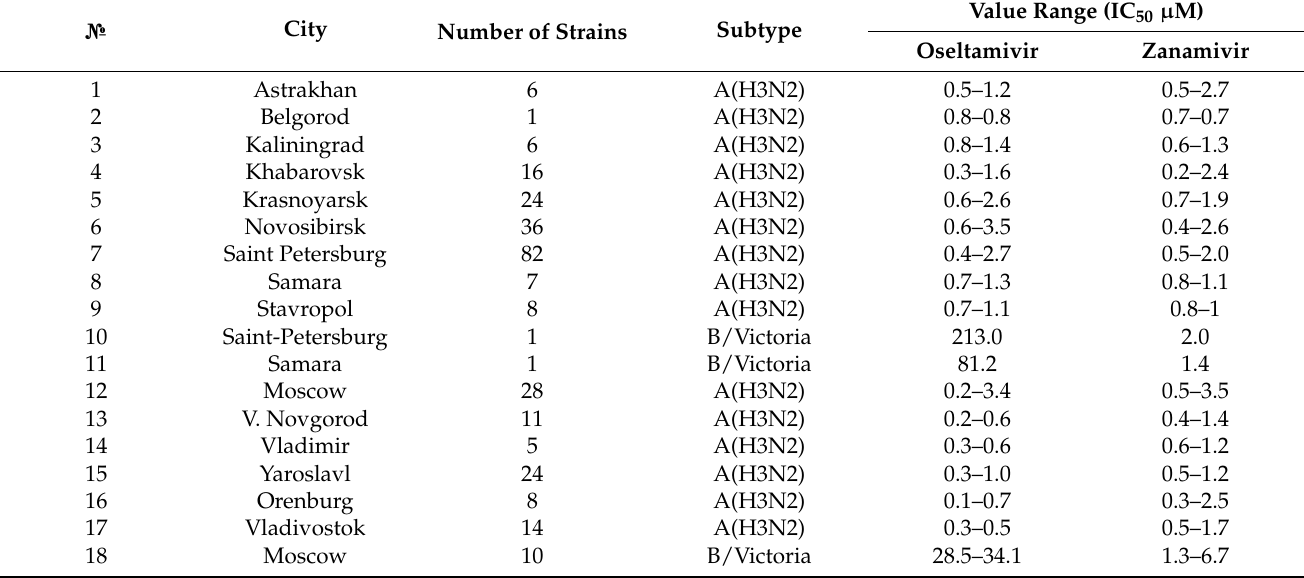
Table 2. Susceptibility of influenza viruses circulating in the Russian Federation to